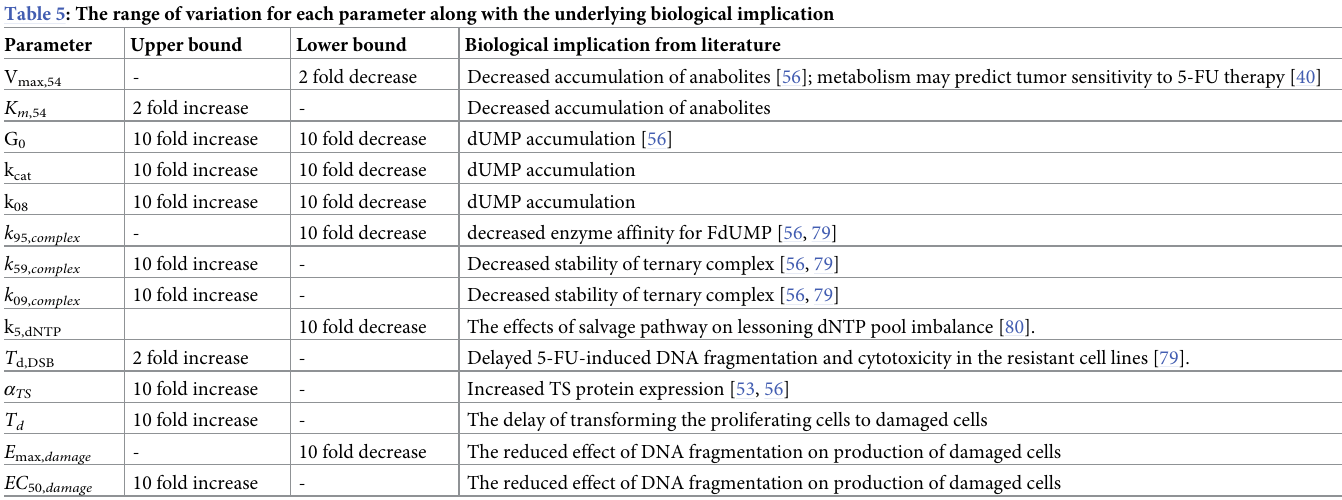
Table 6. The range of variation for each parameter and their corresponding biological implication. Table 5: The range of variation for each parameter along with the underlying biological implication Parameter Upper